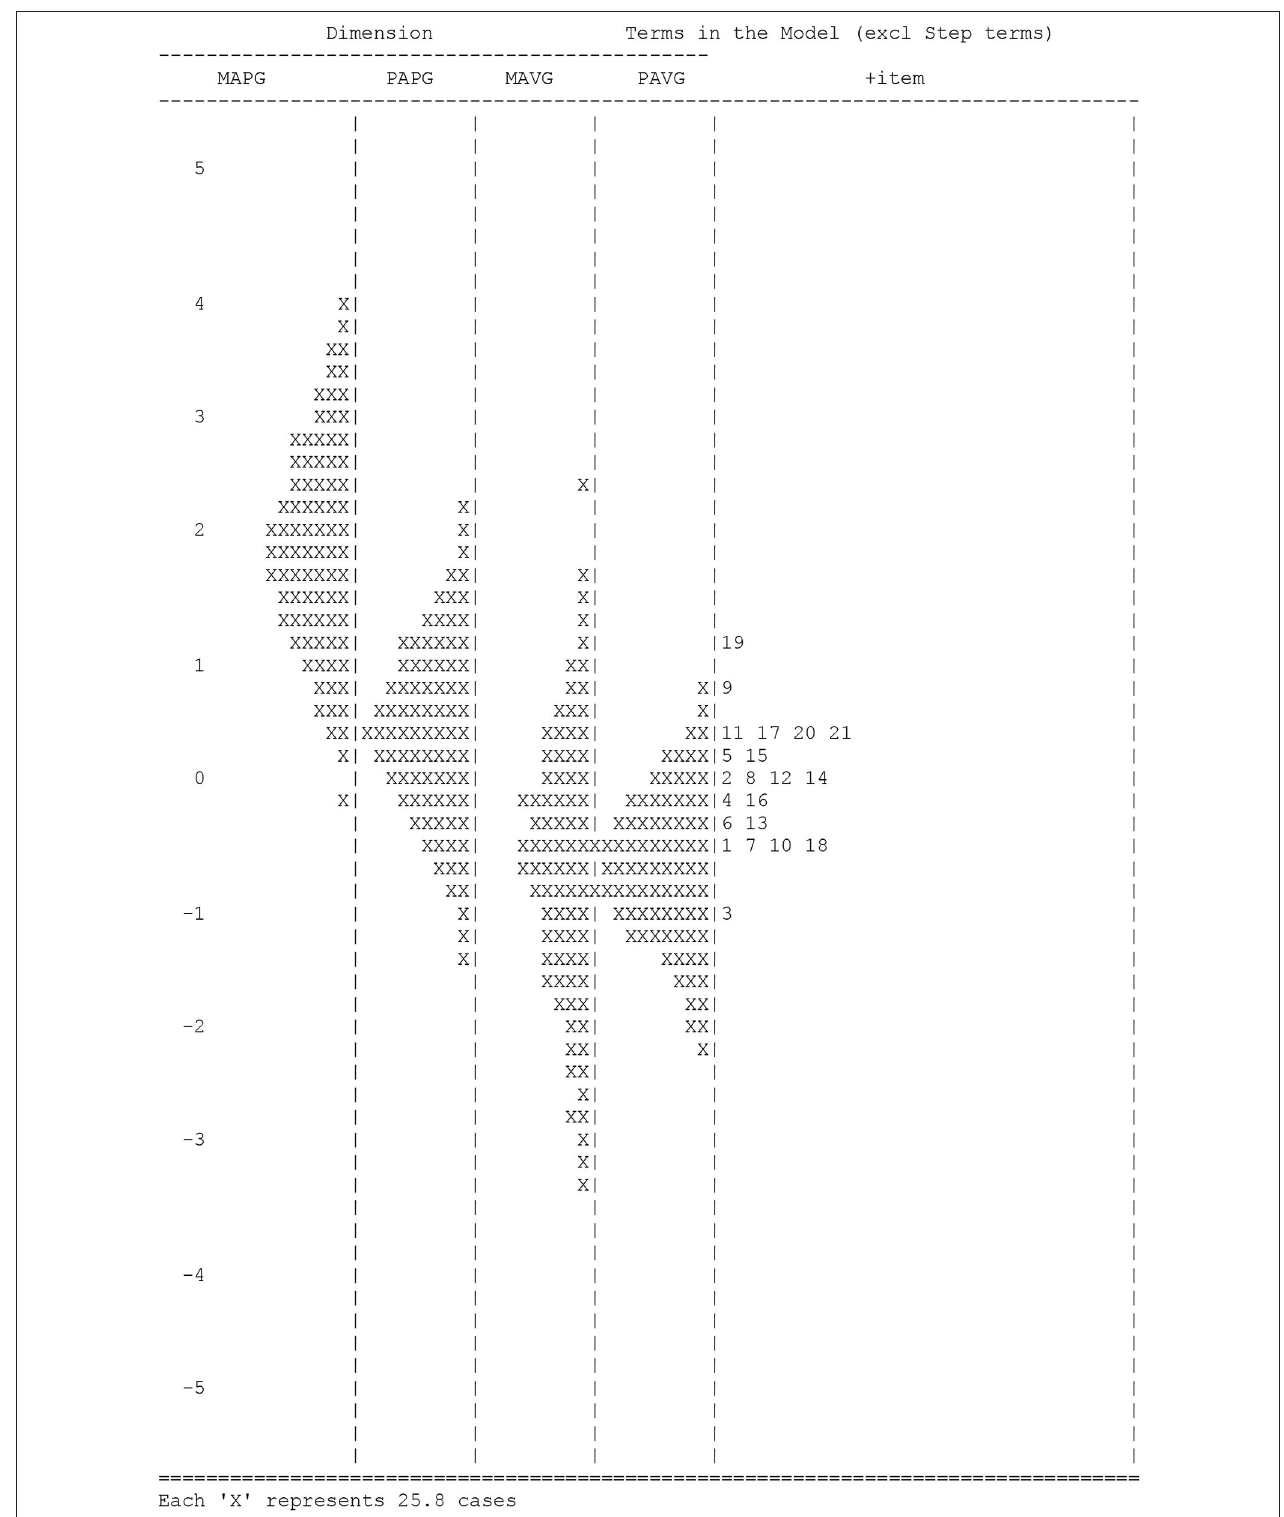
FIGURE 1 | Item-person